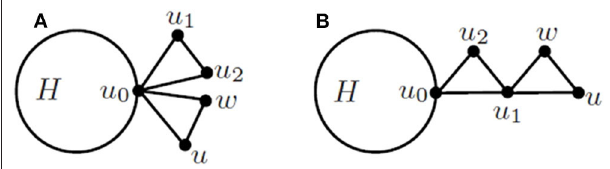
FIGURE 5 | (A) The network G . (B) The network G ′